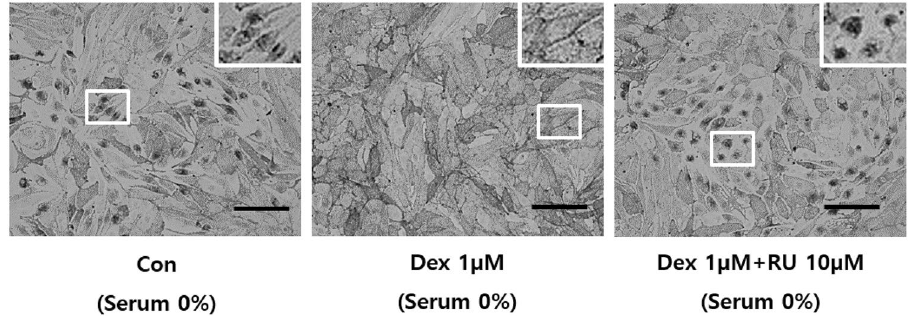
Figure 1. The GR agonist, Dex, induces melanosome movement. Melan-a melanocytes were cultured in serum- free medium with or without pretreatment for 30 min with 10 µM Ru486 before treatment with or without 1 µM Dex for 72 h. Melanosome distribution was observed using bright field microscopy at × 400 magnification. Higher magnification images of the areas denoted by white boxes are located at the upper-right of each panel. (scale bar = 100